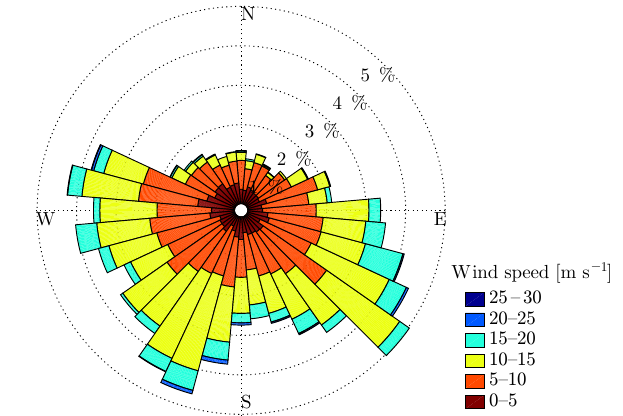
Figure 2. The wind climate at hub height in the middle of the An- holt wind farm for the year 2014 based on WRF